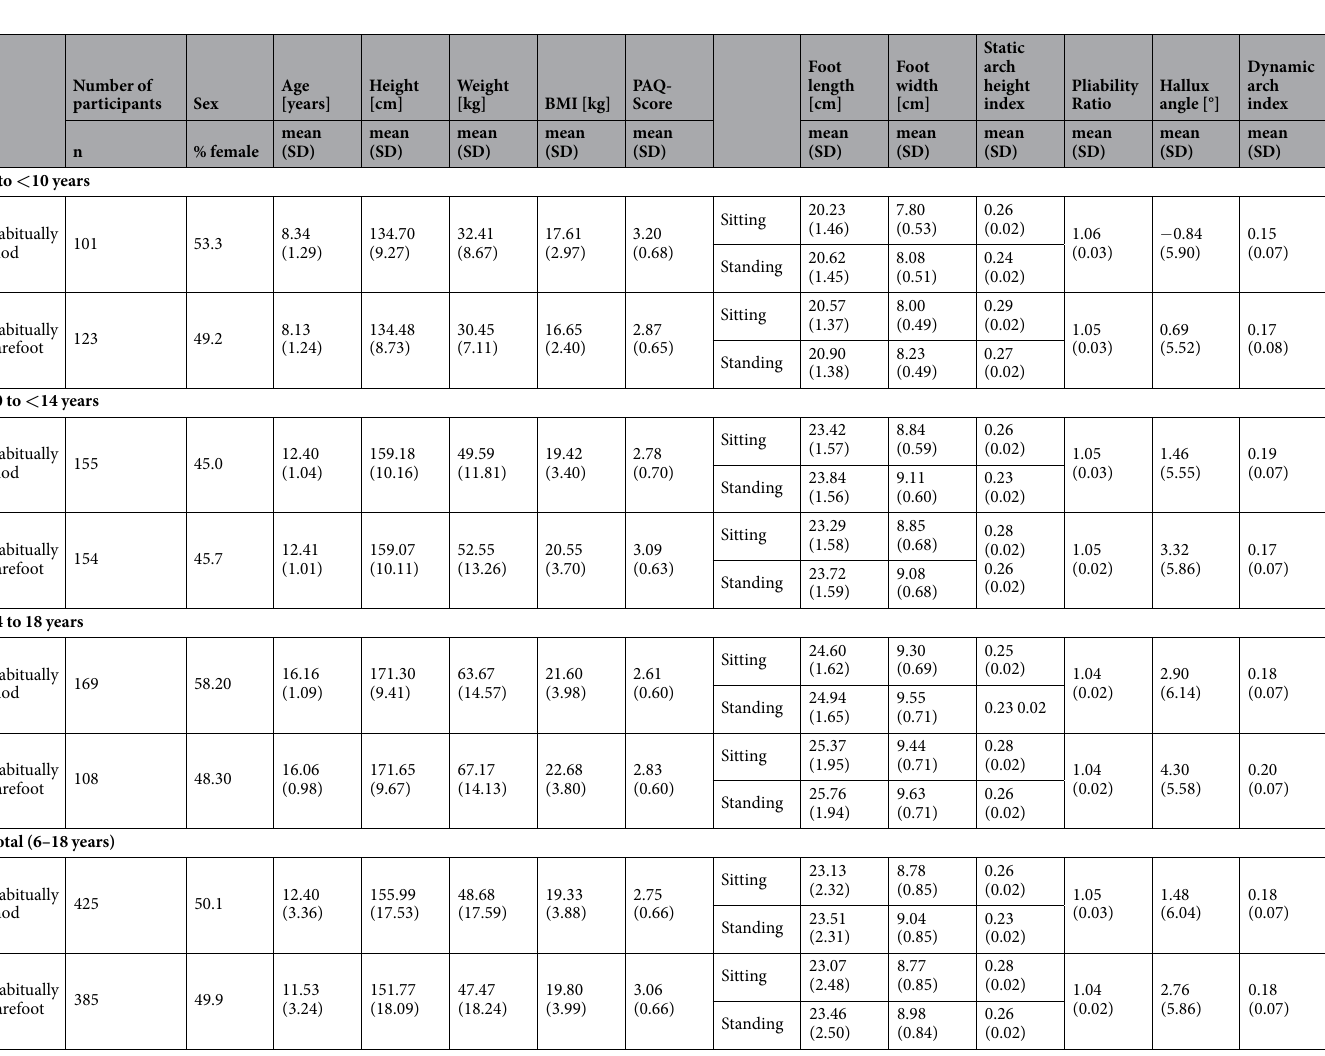
Table 1. Descriptive statistics of all habitually barefoot and habitually shod children included in the analysis.